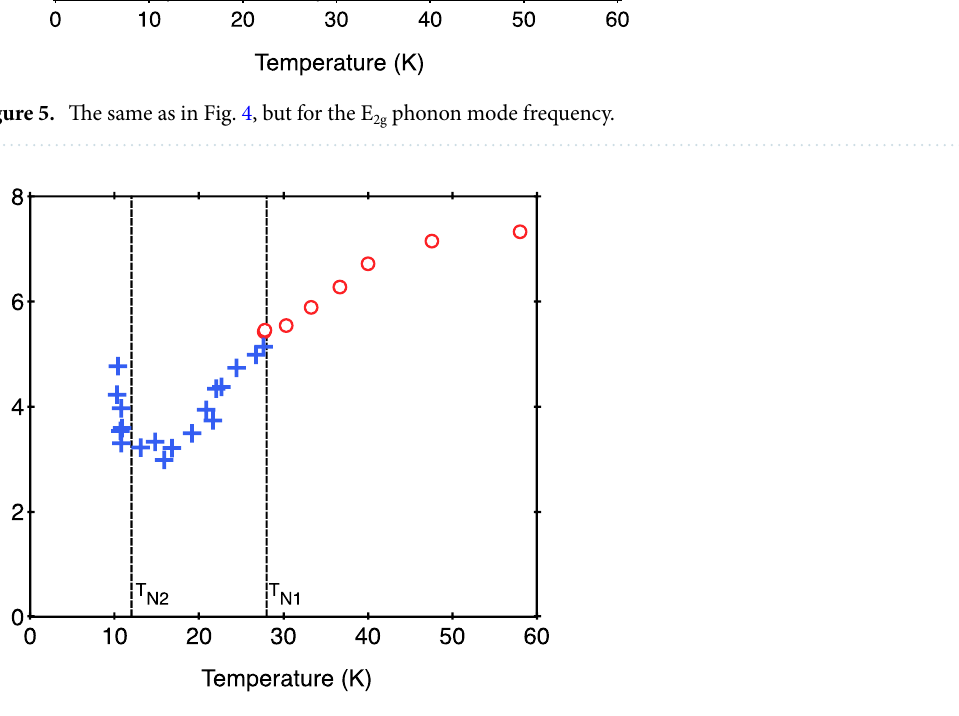
Figure 6. Temperature dependence of the E 1g mode line width from Raman scattering